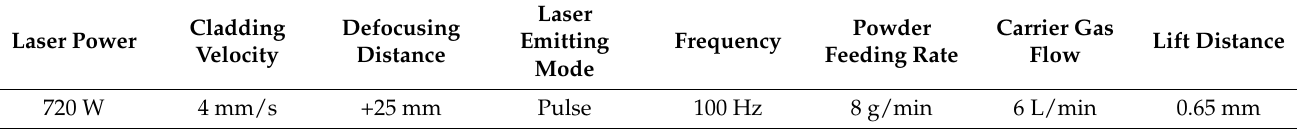
Table 2. Laser cladding process parameters in